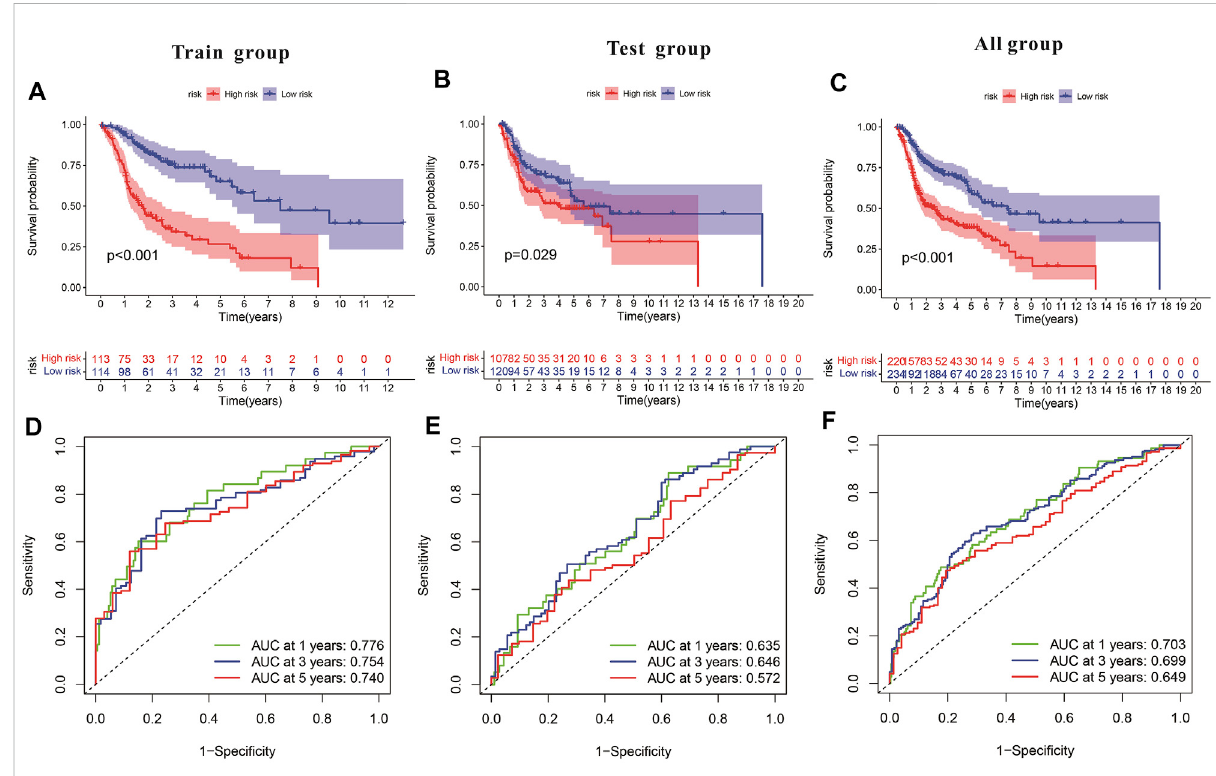
FIGURE 9 Characteristics of the pyroptosis-related gene signature in training and testing cohorts. (A – C) Kaplan-Meier analysis of training and testing cohorts and all groups revealed that patients at high risk had poorer survival. (D – F) Risk model in ROC curves at 1, 3, and 5